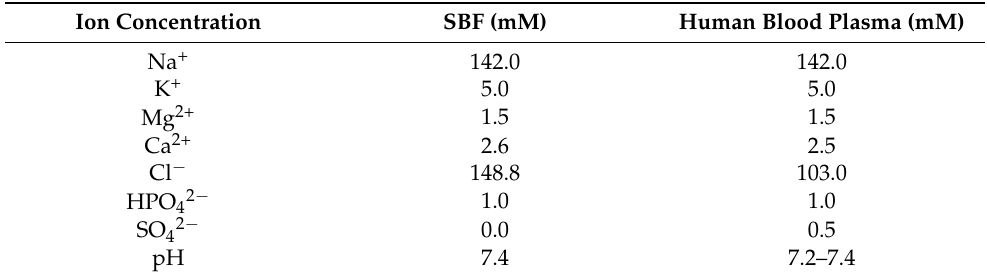
Table 8. Ion concentrations of SBF and human blood plasma. Data from Vallet-Regi and Kokubo and Takadama